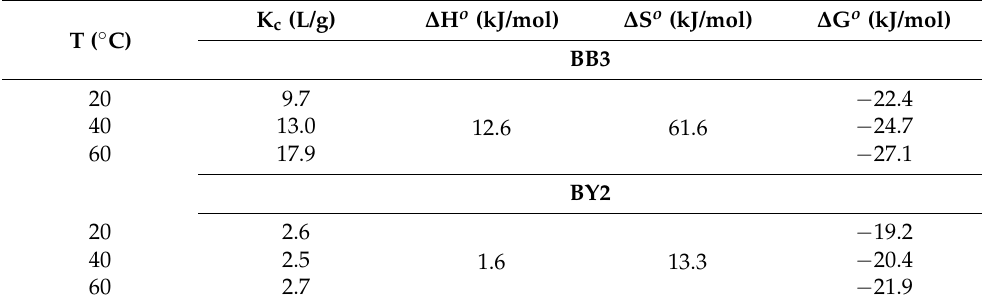
Table 5. Thermodynamic parameters of BB3 and BY2 adsorption on C/SiO 2 composite.